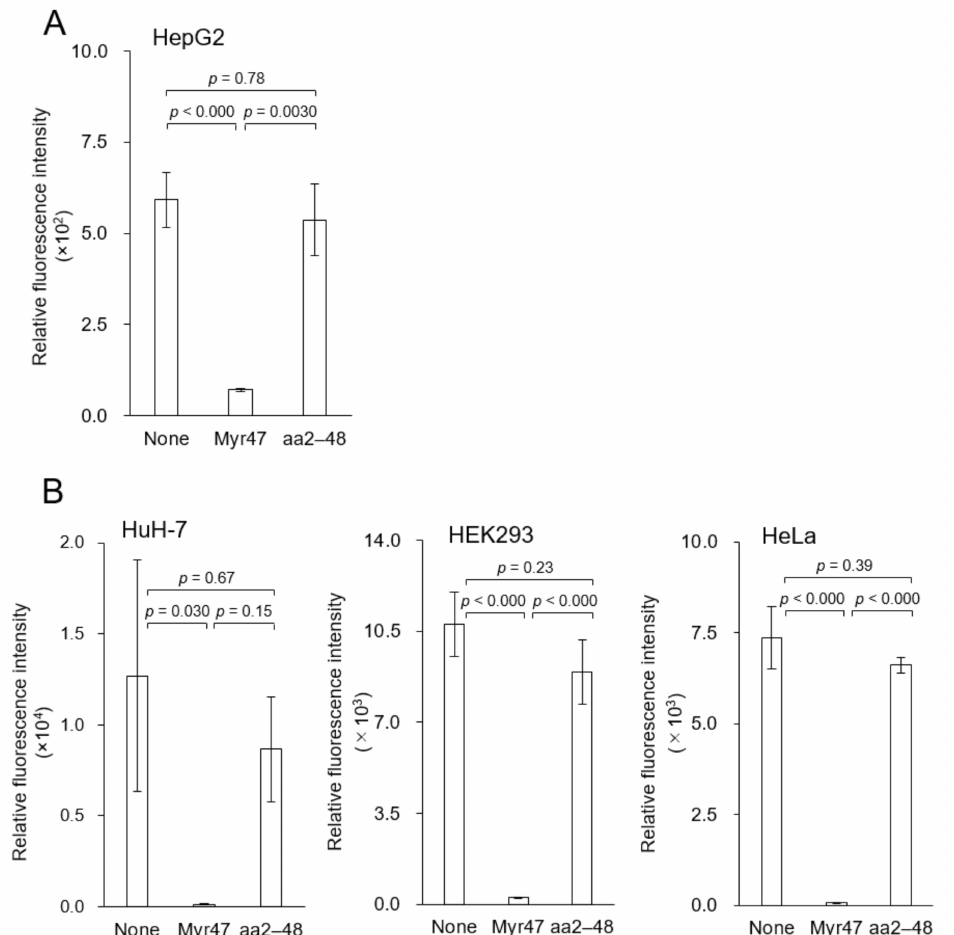
Figure 2. Inhibitory effect of Myr47 on the cellular LP uptake by various cells (no NTCP expression). ( A ) Hep G2 cells. ( B ) Huh-7 cells, HEK293 cells, and HeLa cells. Cells were incubated with DiD-LPs (5 µ g/mL) in serum-free DMEM containing Myr47 or its mutant aa2–48 (500 nM) for 3 h at 37 ◦ C, and then analyzed with flow cytometry. Data are shown as means ± S.D. ( n =